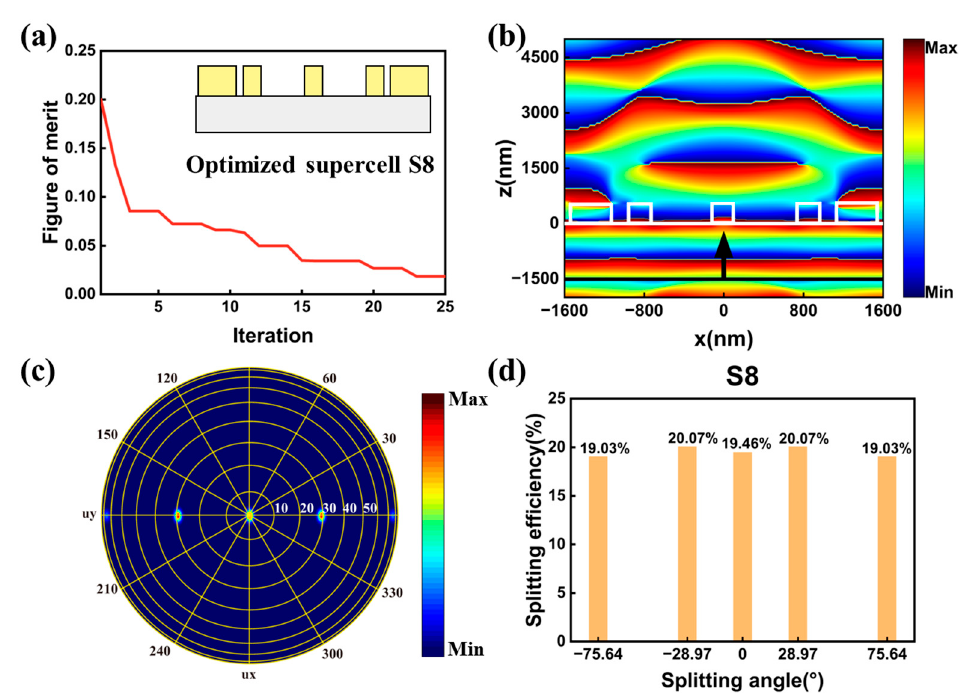
Figure 6. ( a ) The optimization trajectory of metasurface for five ‐ port splitting output. The insert is the side view of the optimized supercell. ( b ) The phase distribution profile of electric field Ex in the x-z plane for the optimized supercell S8. The white lines depict the boundaries of the nanocylinders and substrate, and the black line and arrow represent the location and direction of the incident light. ( c ) The far field distribution of the splitting channels. ( d ) The calculated efficiencies at different splitting channels in supercell S8.